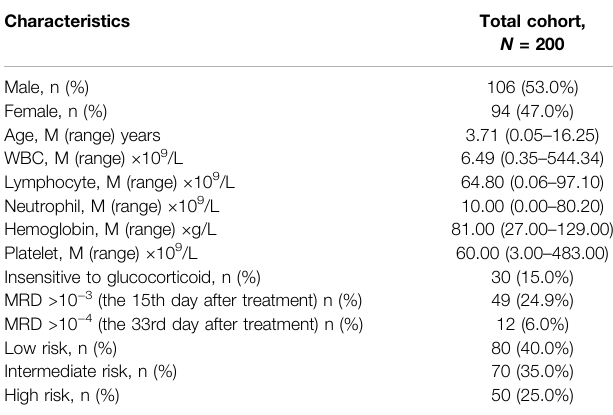
TABLE 1 | Clinical and genetic features in 200 B-ALL patients.